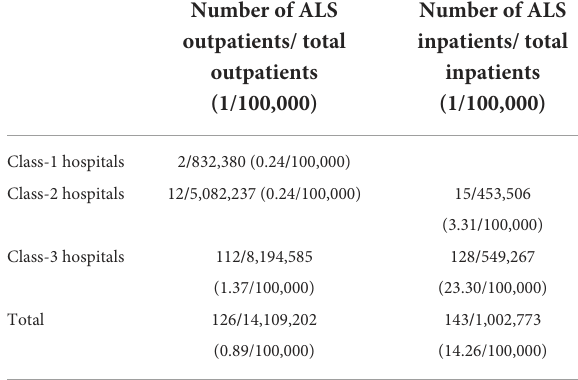
TABLE 2 Prevalence of ALS in urban and rural districts of China mainland in population survey.